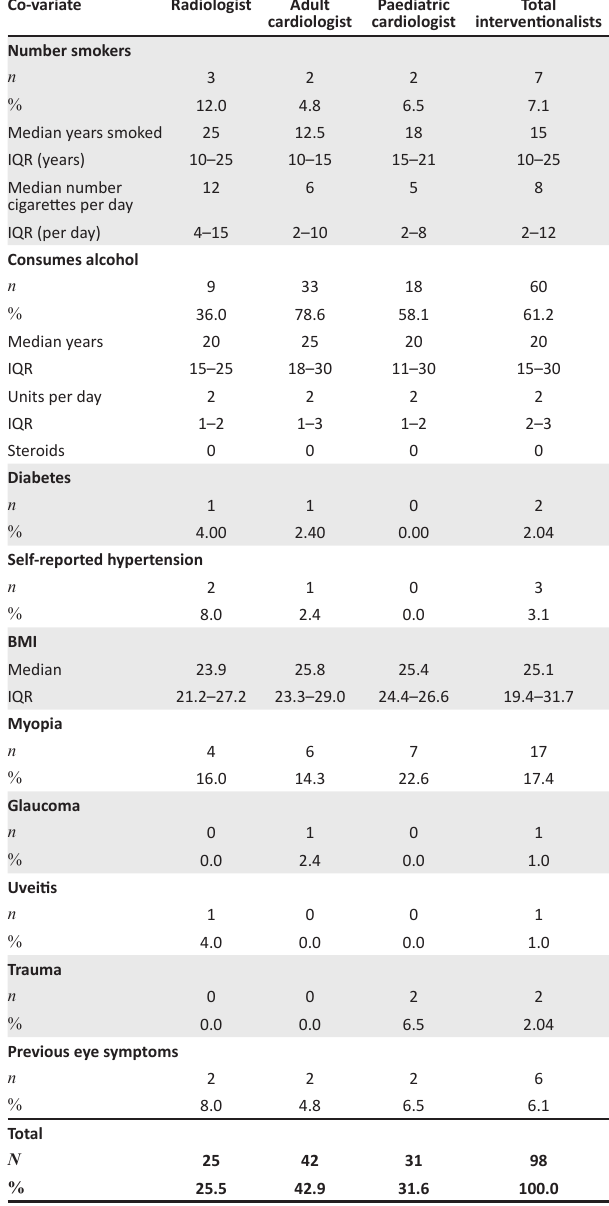
TABLE 2: Self-reported risk factors and co-morbid diseases in 98 interventionalists.